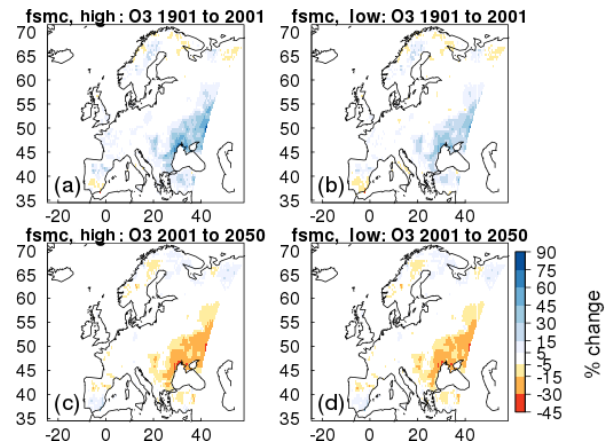
Figure 5. Simulated percentage change in plant available soil mois- ture (fsmc) due to O 3 effects at fixed pre-industrial atmospheric CO 2 concentration (run_O 3 ). Changes are shown for the periods 1901 to 2001 and 2001 to 2050 for the high and low plant O 3 sen-